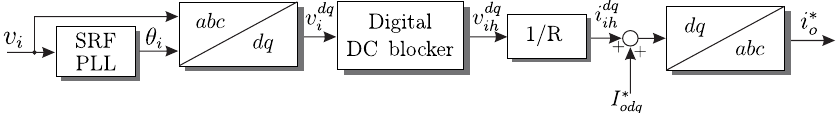
Figure 9. Output current reference generation for active damping